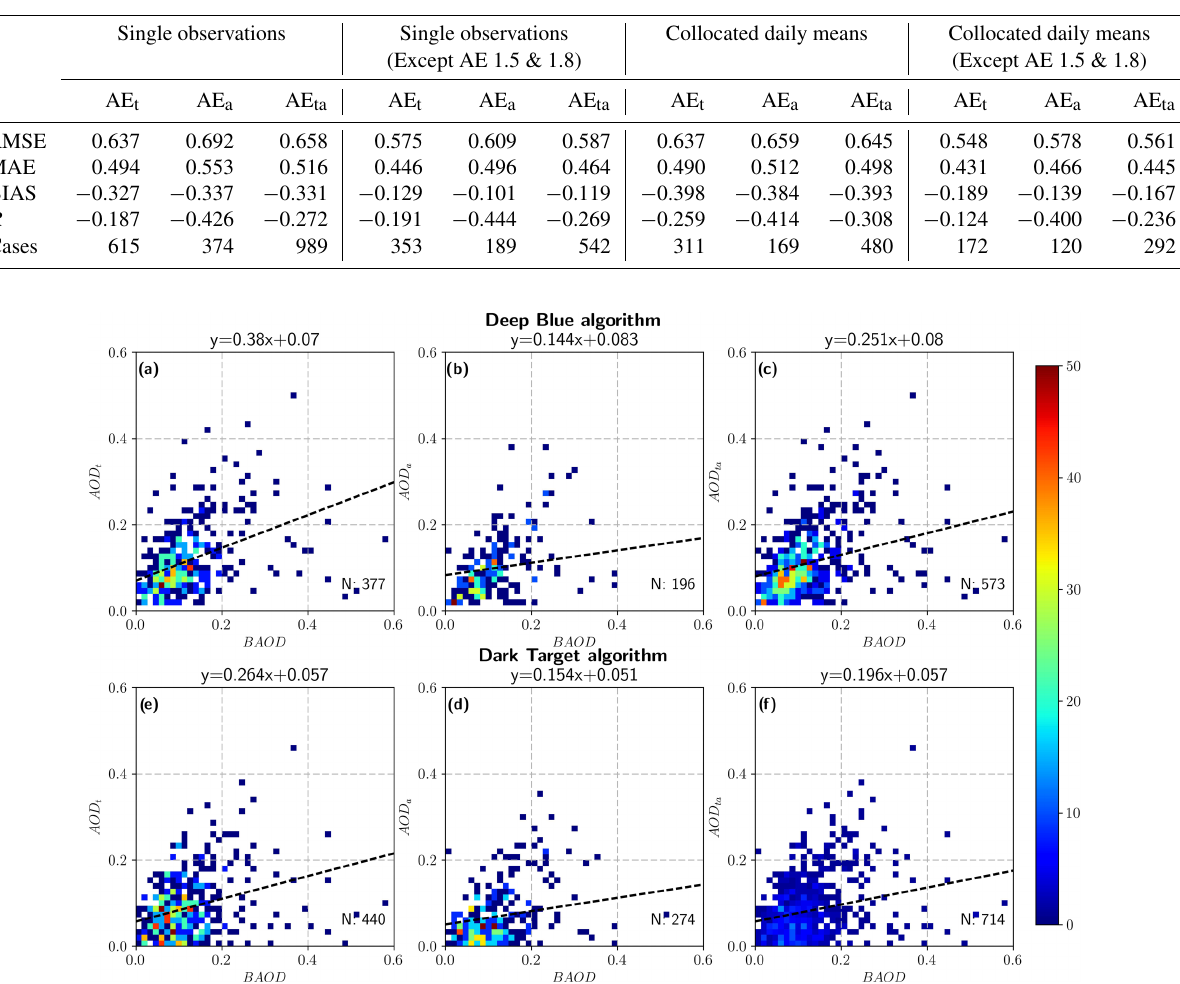
Table 6. Statistics from comparing AE t , AE a and AE ta with AE SP for single observations and daily mean values.